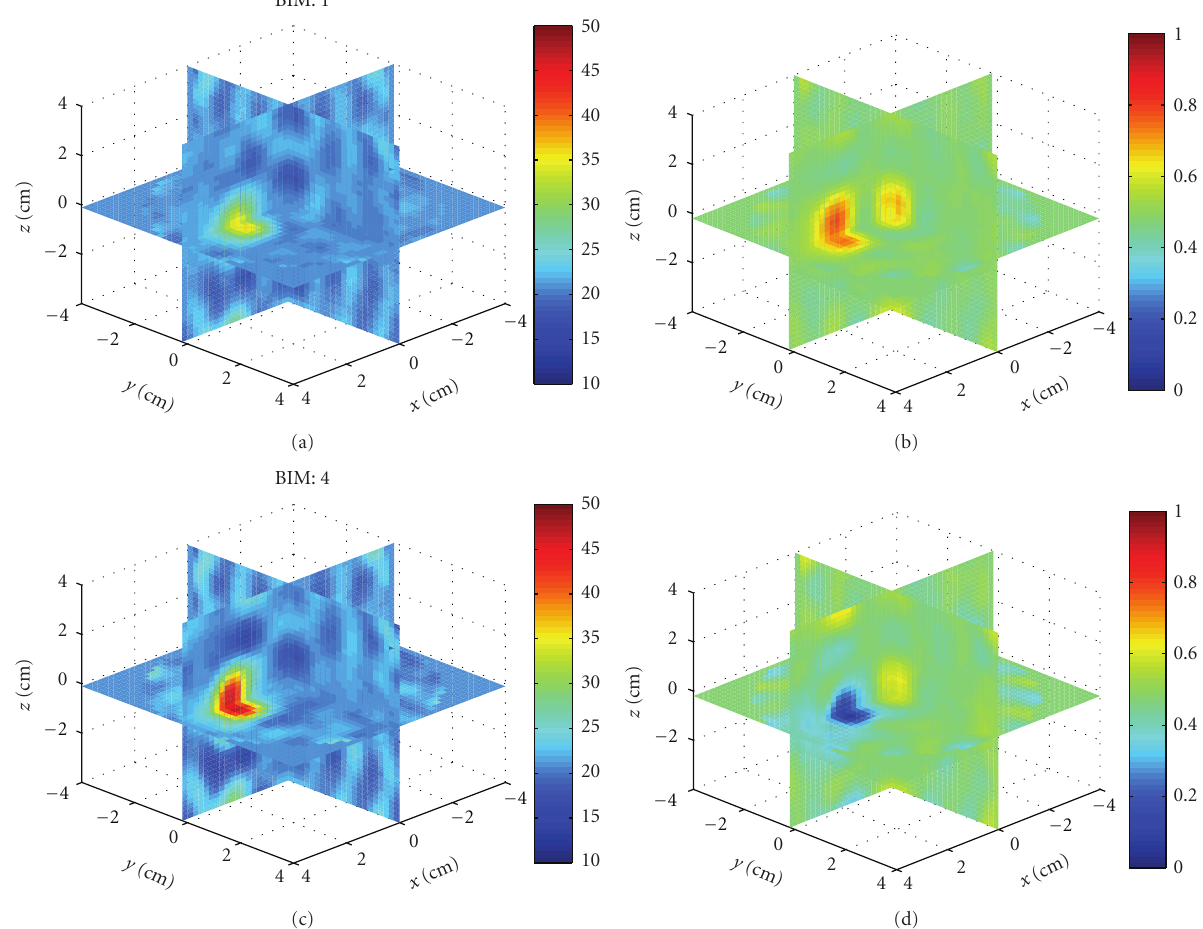
Figure 11: Reconstructions of a single sphere ( (cid:2) r , σ ) = (40, 0) located at ( x , y , z ) = (0,0,2 cm) of Example 1. Born iterations helped retrieve the relative permittivity in (c) and are essential in recovering the conductivity in